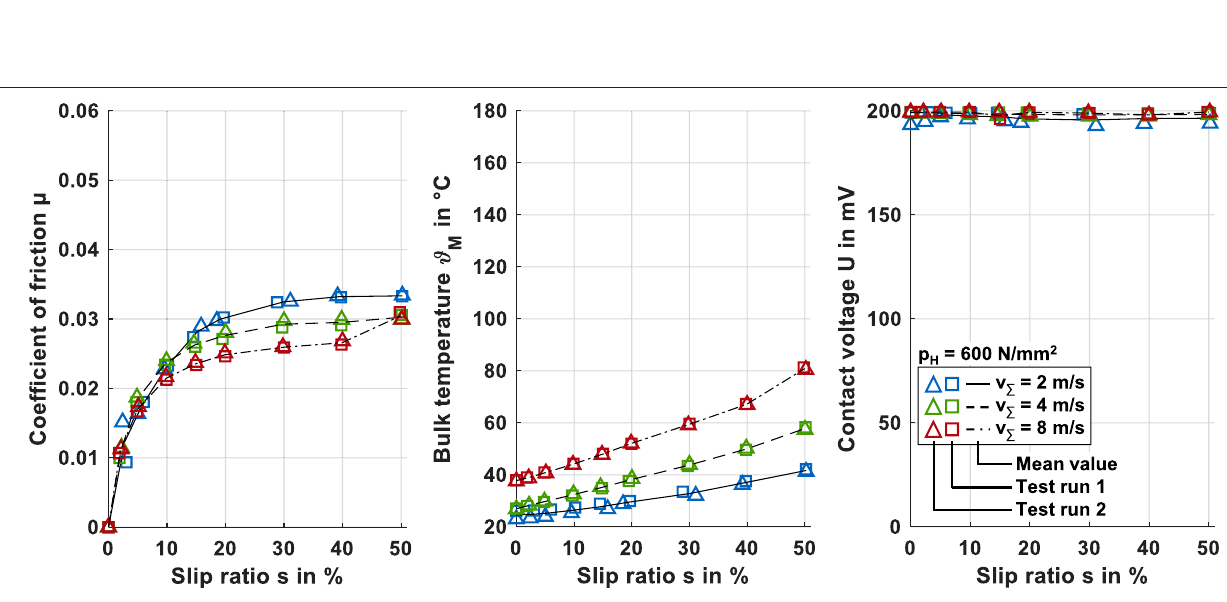
Frontiers in Mechanical Engineering |